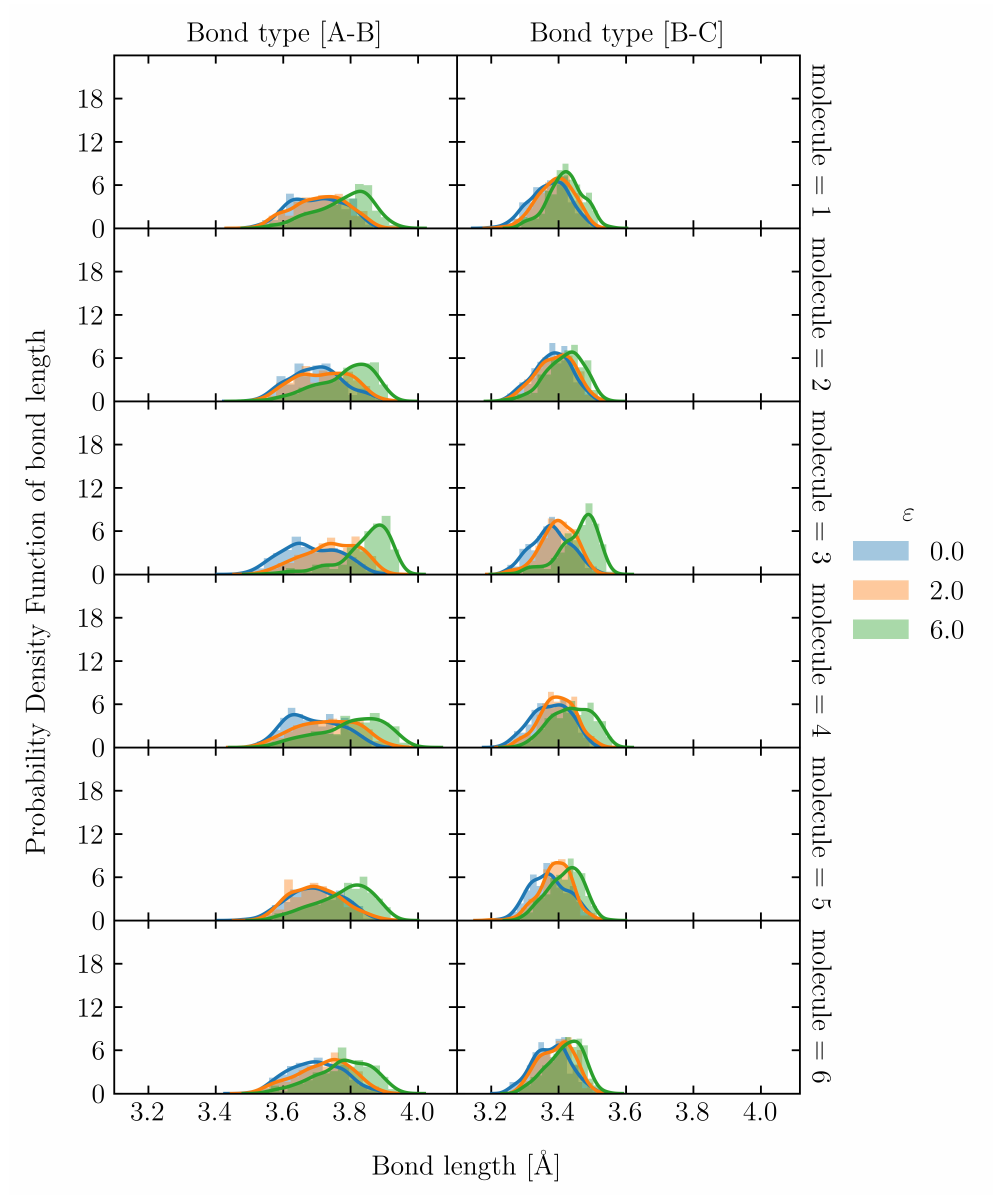
Figure 10. Bond length distribution of S1 at ε = 0.0, 2.0 and 6.0 in 6 representatives out of 32 molecular chains. The solid lines are kernel density estimation over the